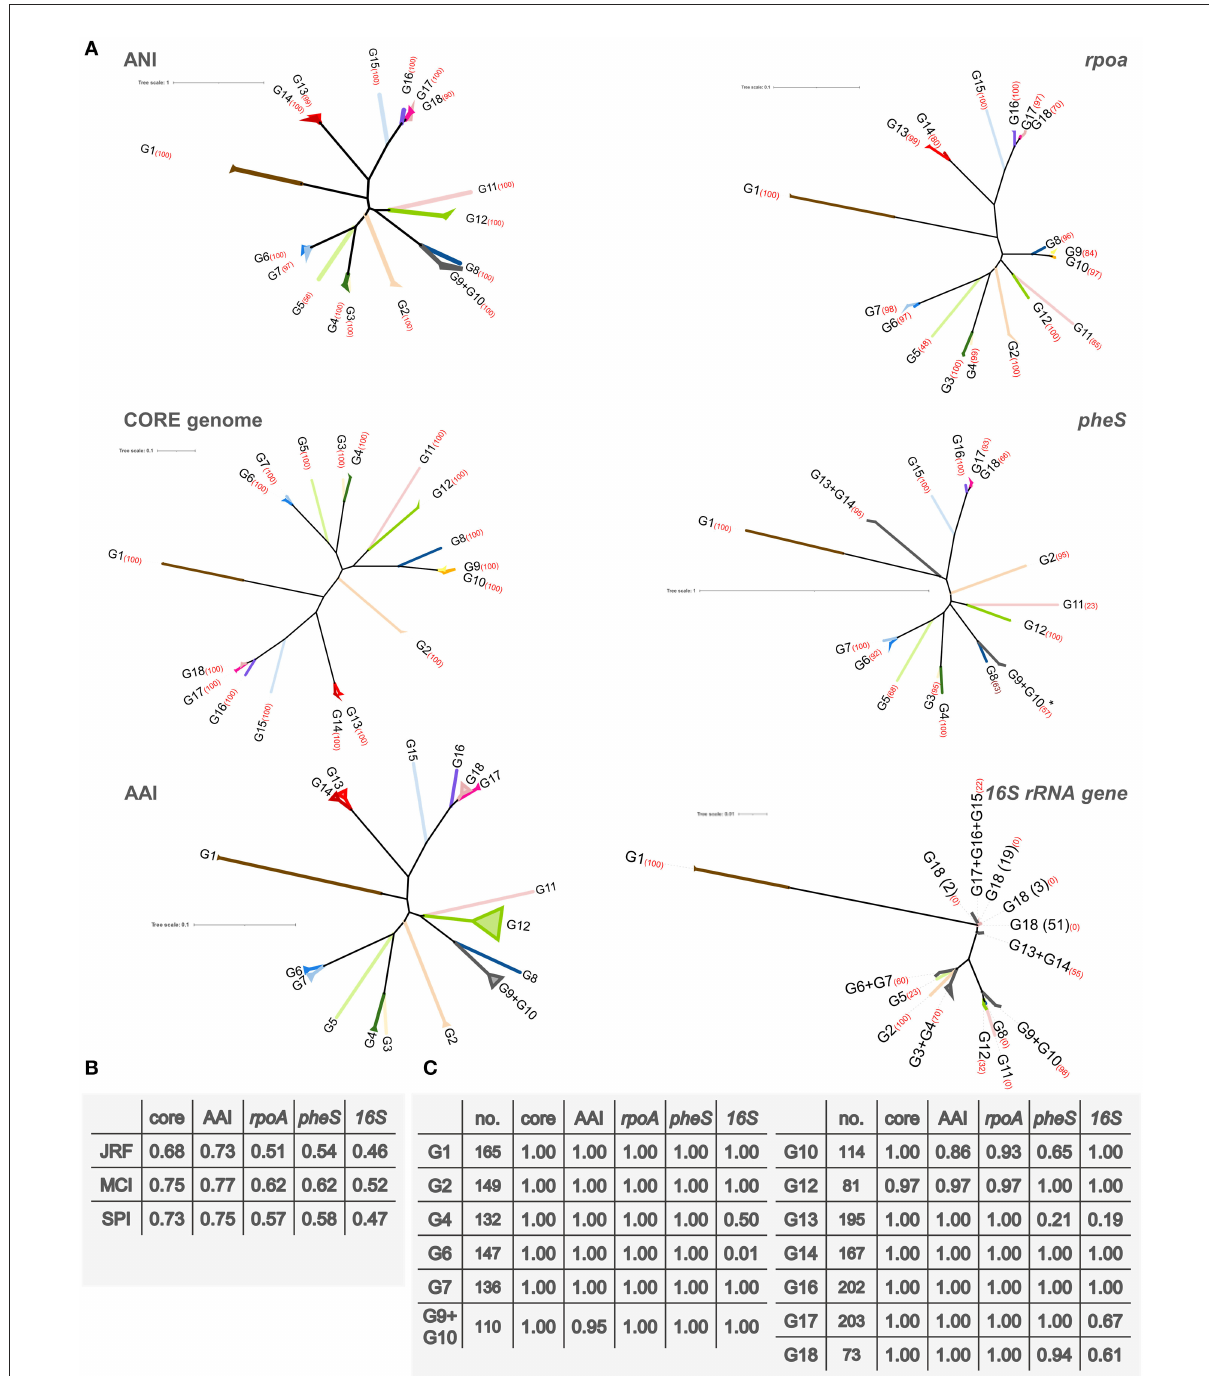
FIGURE4 (A) Phylogenetic trees representing ANI distances and the alignment of the core genome, rpoA , pheS, and the 16S rRNA gene. For core genome, rpoA , pheS, and 16S rRNA genes trees, an alignment was produced with Clustal Omega, respectively, and it was used to infer a tree using RAxML. ANI tree was inferred from the ANI distance matrix with R package APE. AAI distance matrix was used to compute the UPGMA tree. Strains are collapsed into their corresponding group. The percentage bootstrap value of each clade is reported in red brackets. * For clarity of representation, the strain L. lactis AV1N that harbored a highly divergent pheS sequence, was not included. (B) Comparison of the ANI tree with the other phylogenetic trees. Normalized similarity score obtained with the generalized Robinson–Foulds metrics Jaccard–Robinson–Foulds (JRF), Mutual Clustering Information (MCI), and Shared Phylogenetic Information (SPI) are reported. (C) JRF scores of the 15 groups identified in the ANI